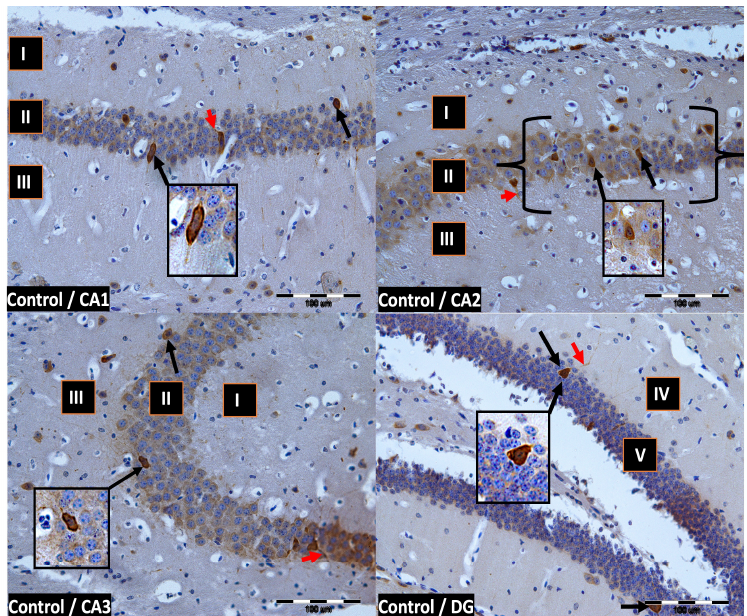
Figure 2. Control group. Immunoreactivity of PV-IR neurons in the fields CA1–CA3 and the DG of the mouse hippocampus was observed. I. the marginal layer, II. the pyramidal layer, III. the multiform layer, IV. the molecular layer, V. the granular layer. The arrows indicate PV-IR neurons (black arrow) and PV-IR nerve fibers (red arrow) in the hippocampus. Magnification × 20.